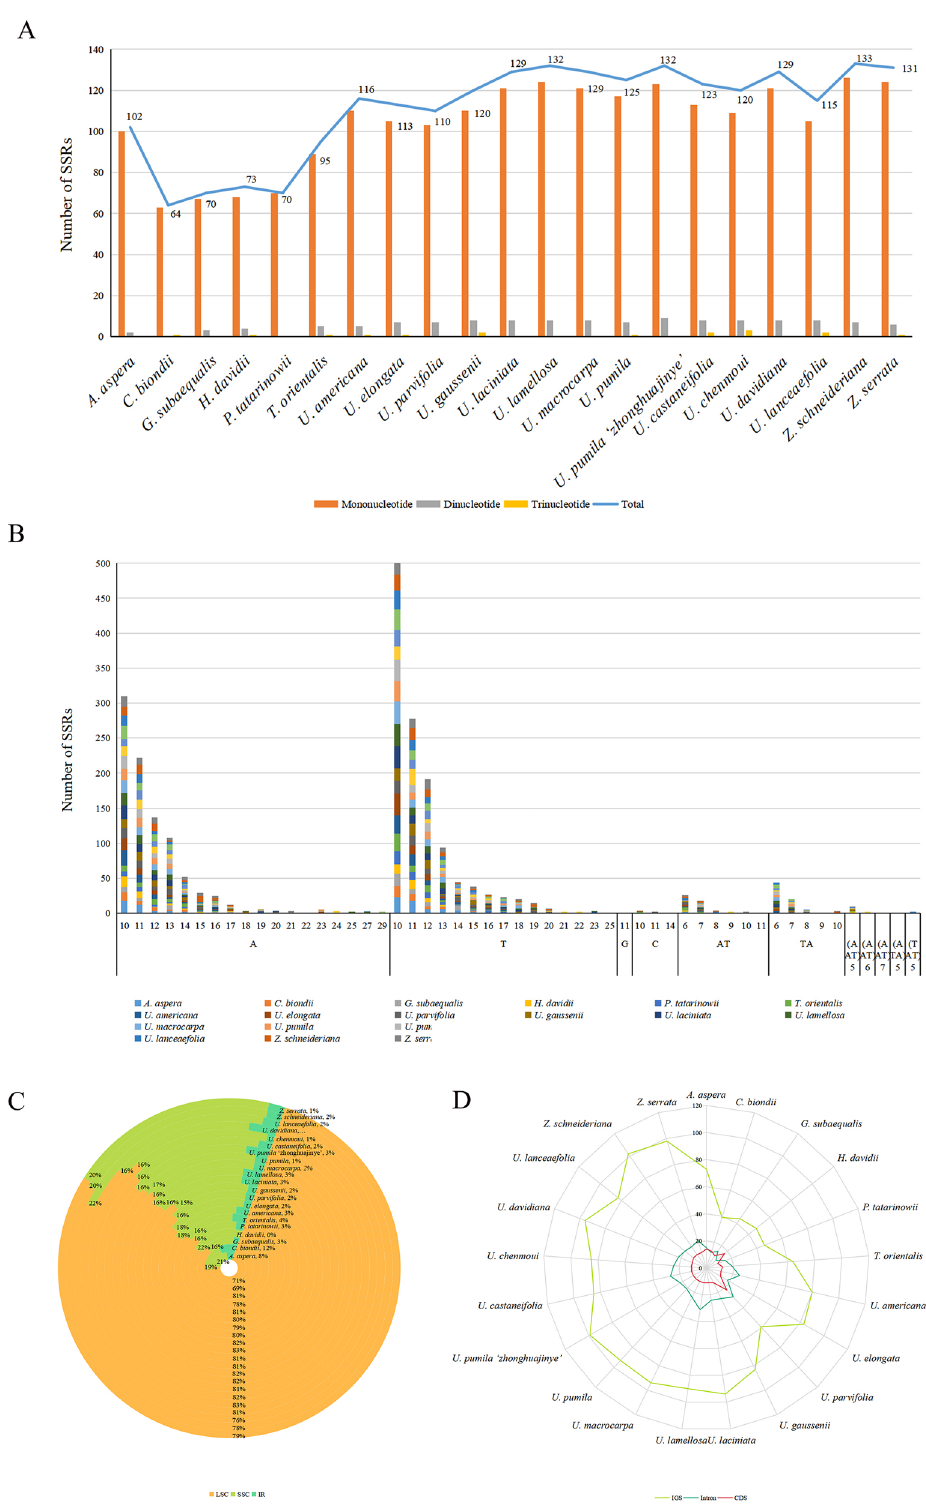
Figure 7. ( A ) Analysis of SSRs in the cp genomes of 21 Ulmaceae species; ( B ) The numbers of SSRs types of 21 Ulmaceae species; ( C ) Frequency of SSRs in the LSC, IR and SSC region; ( D ) Frequency of SSRs in intergenic regions, protein-coding genes and introns